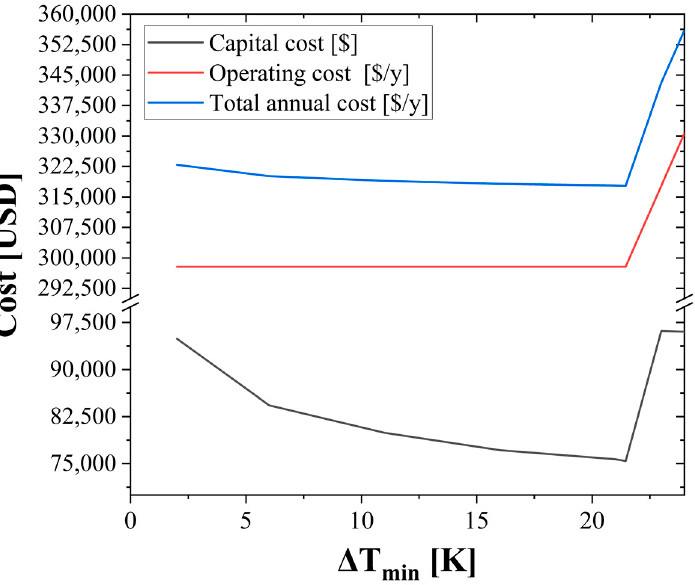
Figure 4. Cost targets of the HEN in the wastewater heat recovery system relative to the change in minimum allowed temperature difference ( ∆ T min ).